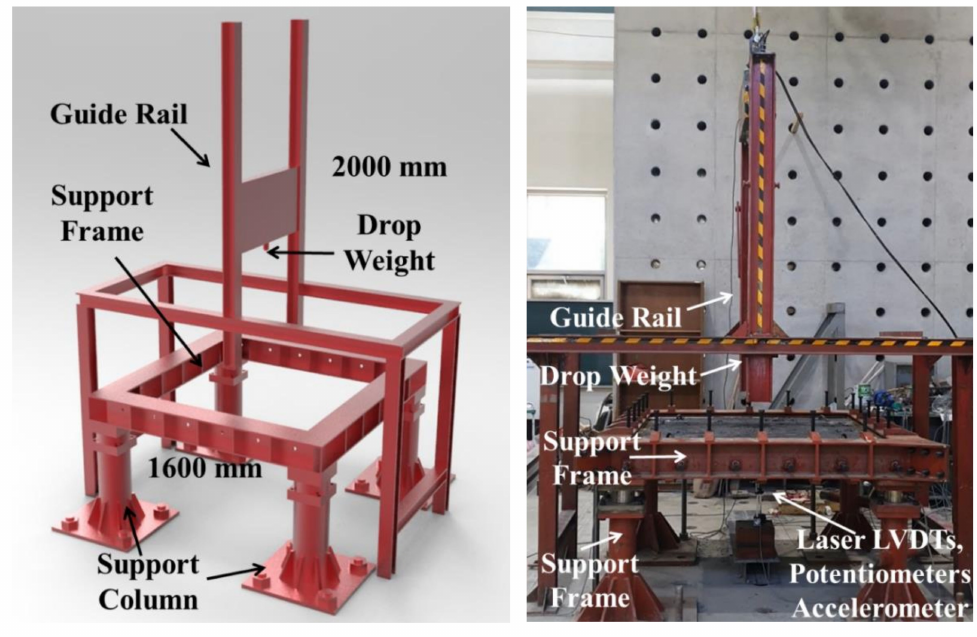
Figure 3. Test setup for drop-weight